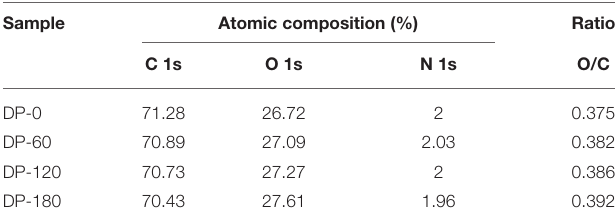
TABLE 3 | Relative atomic composition (C 1s, O 1s, and N 1s) for the four RPA samples in DP-0, DP-60, DP-120, and DP-180 groups.